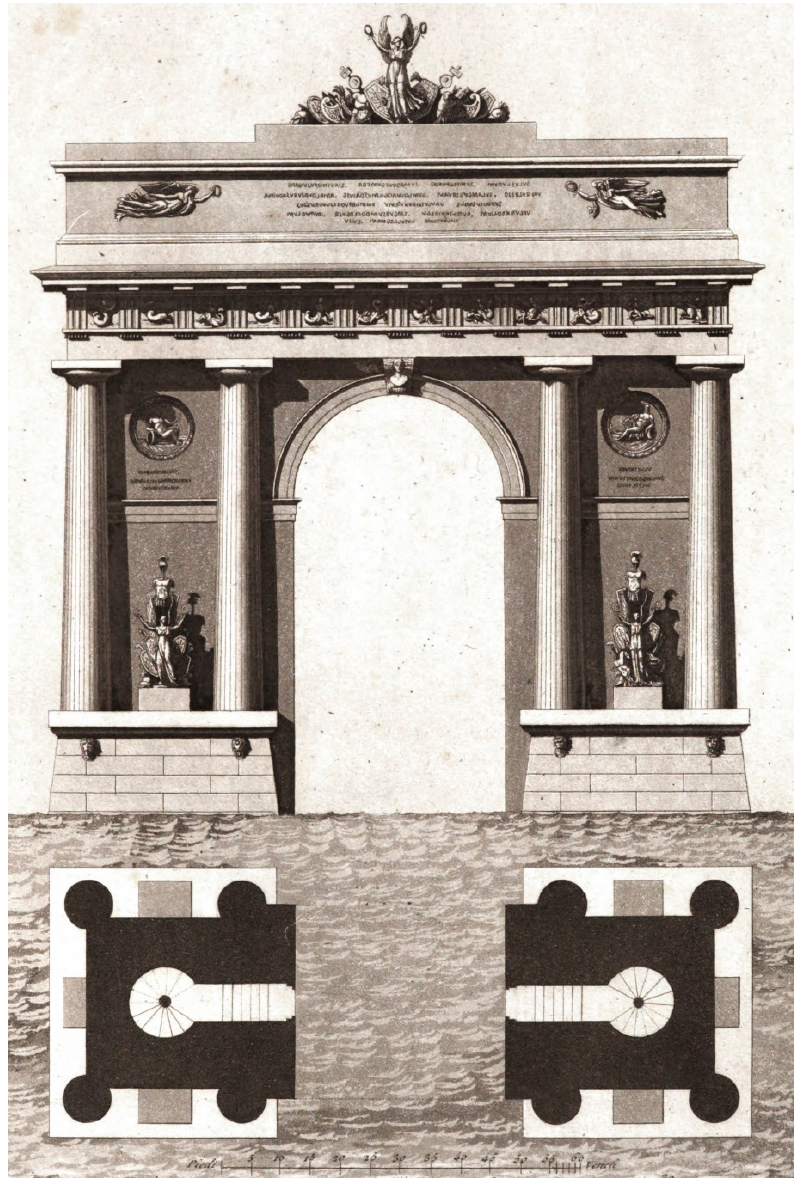
Figure 9. G. Selva, The Triumphal Arch built for Napoleon I’s visit to Venice in 1807, engraving, 1807–1808, Museo Correr, Venezia.